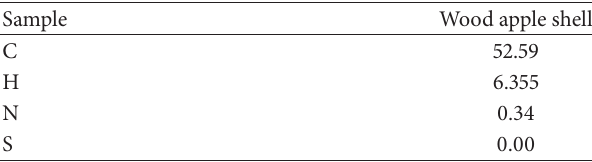
Table 2: Ultimate analysis of wood apple shell particles.